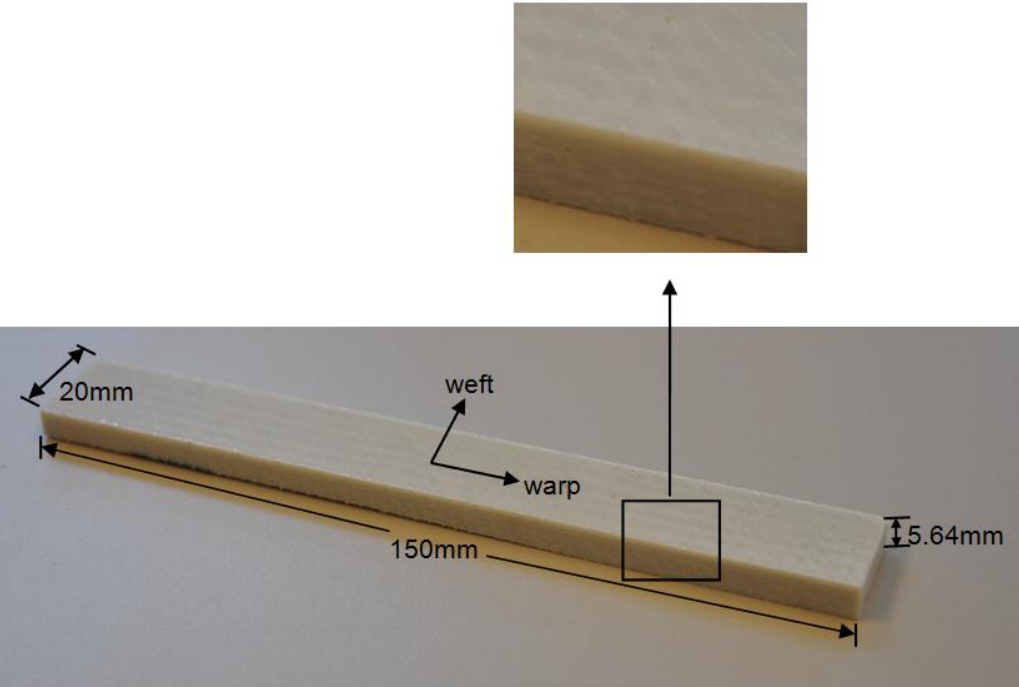
Figure 1. Fibre-reinforced polymer (FRP) laminate specimen for flexural tests. Table 1. Glass-fibre-reinforced polymer (GFRP) laminate properties of EQX1200 (supplied by Owenscorning, Toledo, OH, USA).